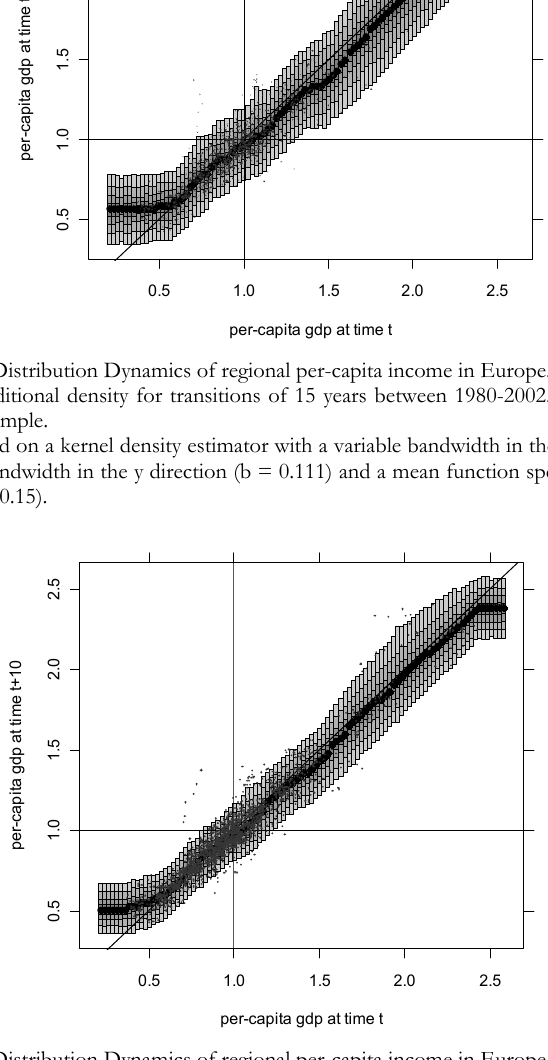
Figure A2 – Intra-Distribution Dynamics of regional per-capita income in Europe. HDR plot of conditional density for transitions of 10 years between 1980-2002. Groningen is ex- cluded from the